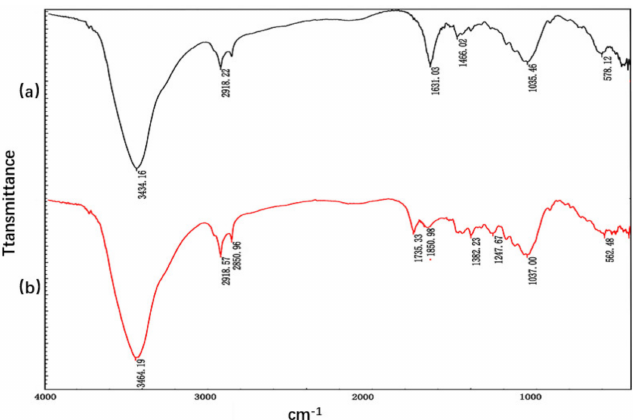
Figure 4. Infrared spectrum of areca fiber ( a ) before treatment and ( b ) after treatment.